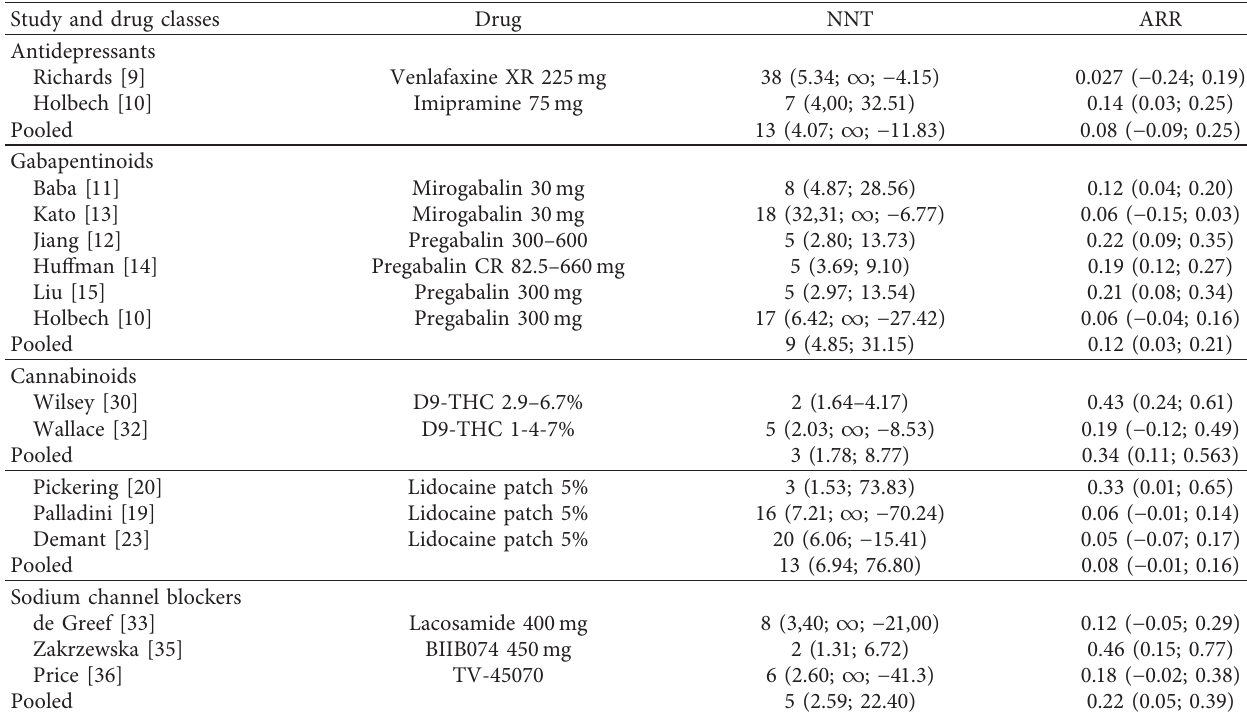
Table 8: Number needed to